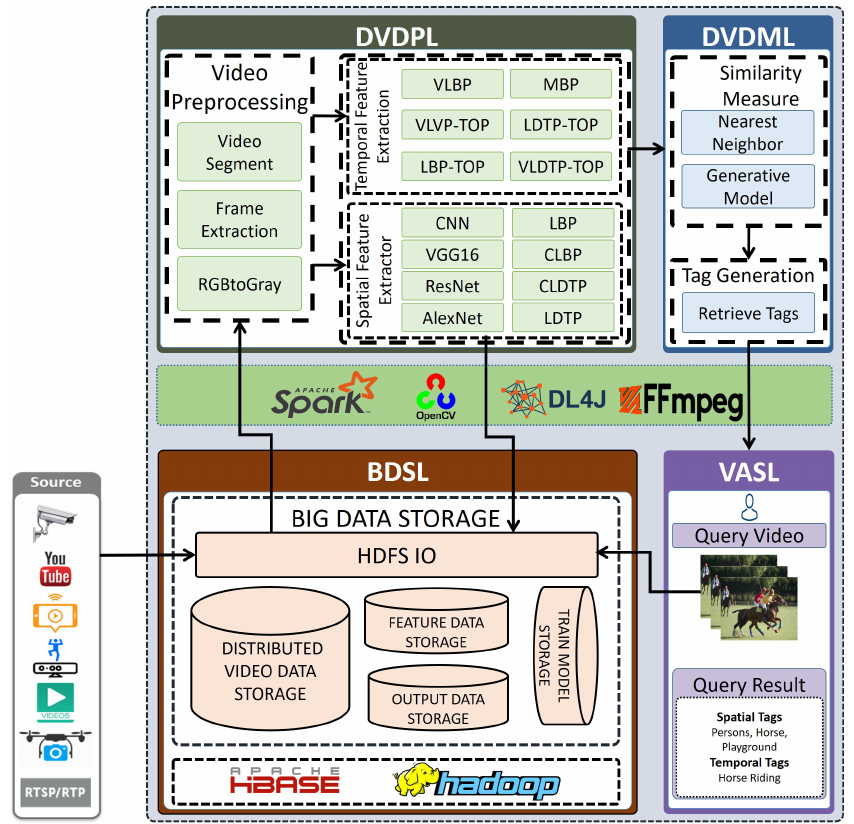
Figure 1. Architecture of the proposed distributed spatiotemporal video annotation